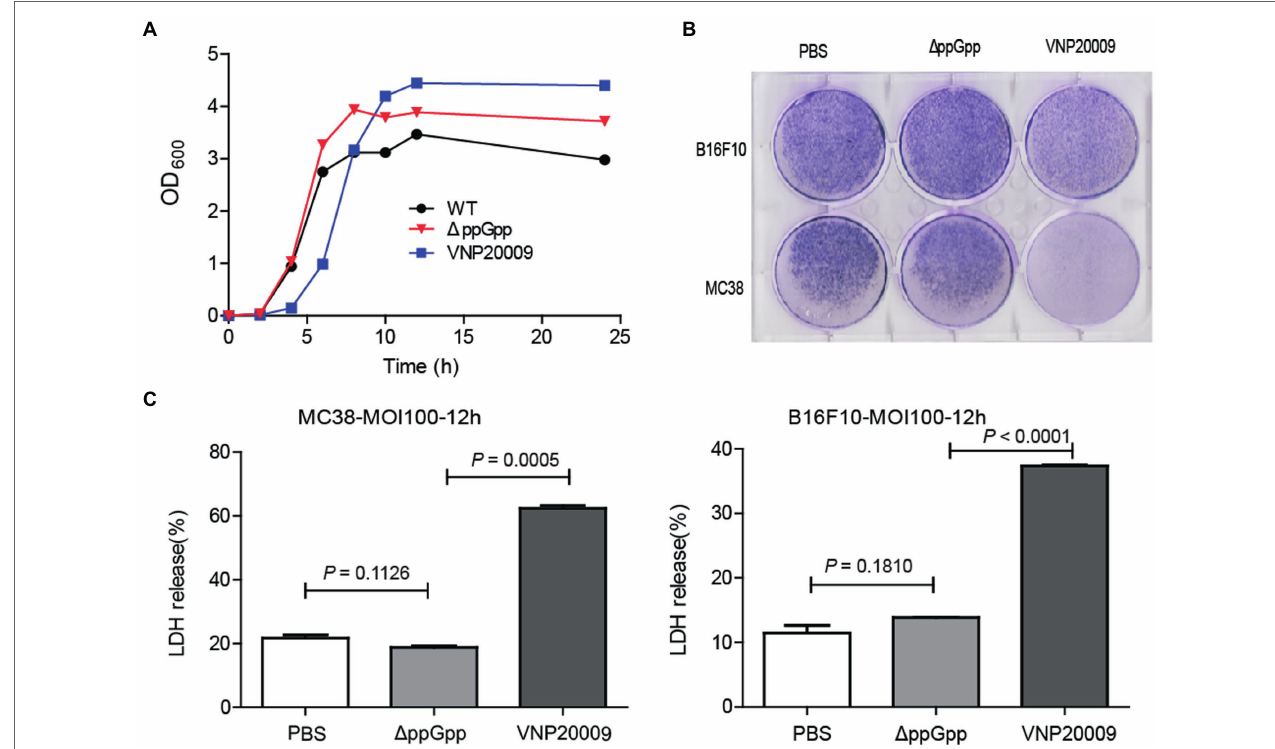
FIGURE 1 | Δ ppGpp showed weaker cytotoxicity than VNP20009 in vitro . (A) At 0, 2, 4, 6, 8, 10, 12, and 24 h, OD 600 of Δ ppGpp, VNP20009, and control group (WT) was measured with a UV spectrophotometer, and the growth curves of the three strains were drawn. (B) MC38 and B16F10 were co-cultured with Δ ppGpp and VNP20009 for 6 h, respectively. After removing bacteria and changing basic DMEM with 150 μ g/ml gentamycin for another 48 h of culture, crystal violet staining was performed to check the viable cells. (C) The LDH released from MC38 and B16F10 cells after co-culture with Δ ppGpp and VNP20009 was determined with LDH assay, p = 0.0005 between Δ ppGpp and VNP20009 in MC38 and p < 0.0001 between Δ ppGpp and VNP20009 in